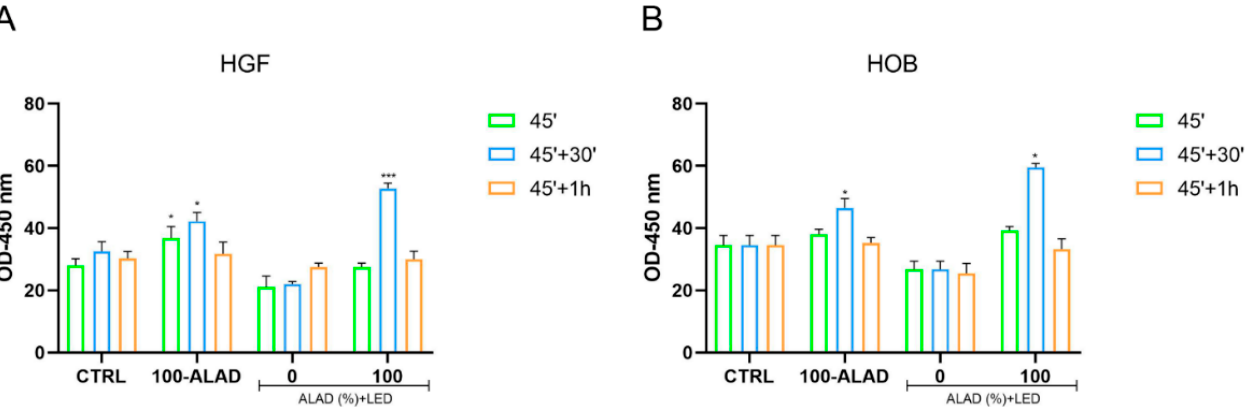
Figure 7. SOD activity. Levels of SOD were detected after the application of ALAD-PDT protocol (45 ′ ) and after 30 ′ and 1 h from its end. Data are expressed as mean ± SD and measured as optical density (OD). A higher SOD activity was observed in ALAD-PDT treated cells after 30 ′ for both cell lines. The statistical analysis was performed by ANOVA test comparing each value to its control (* p < 0.05; *** p < 0.0001).